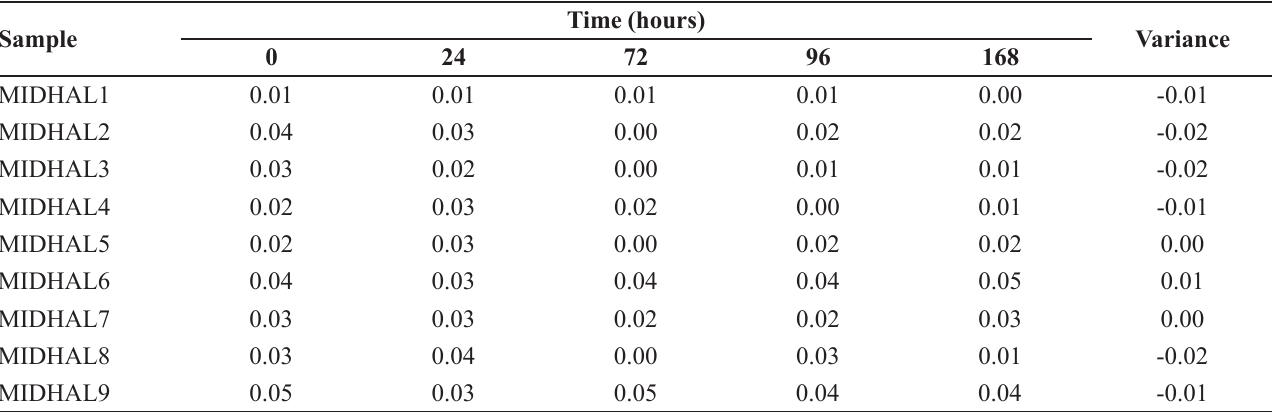
TABLE II - Turbidity measurements in function of the time Sample